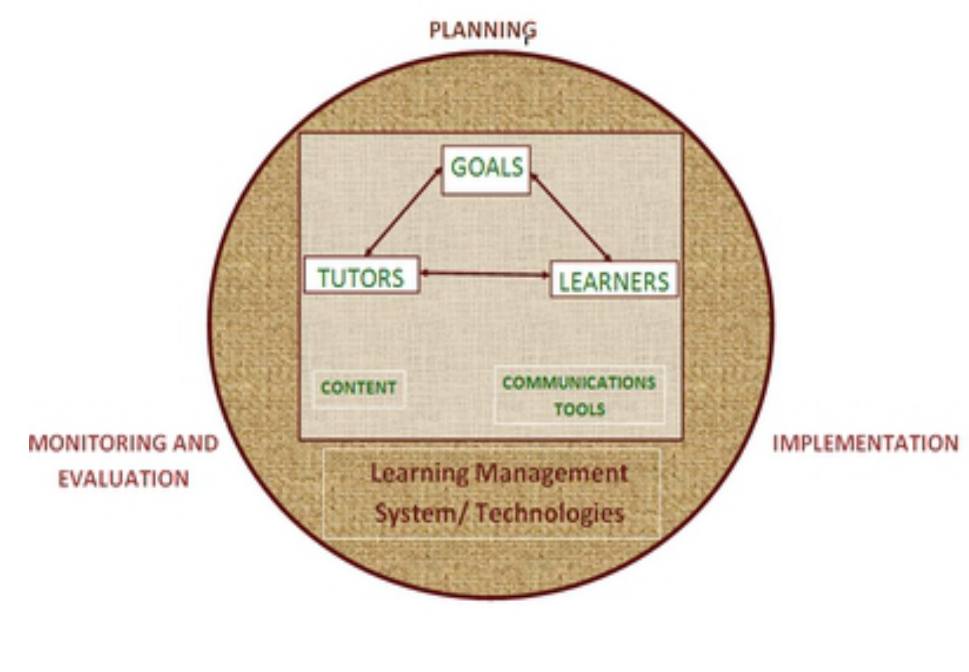
Figure 1: Framework of the